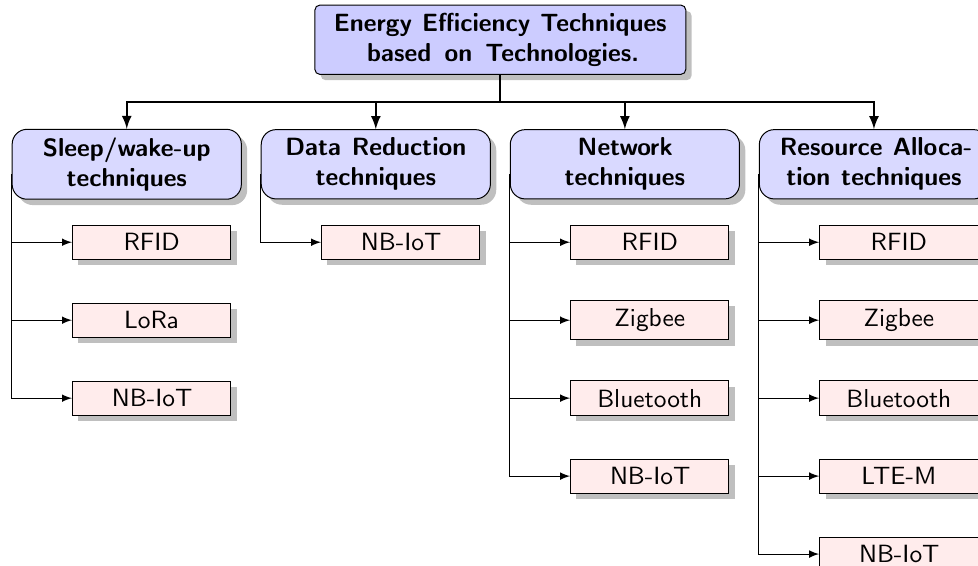
Figure 4. Categories of energy efficiency techniques and mapping based on IoT